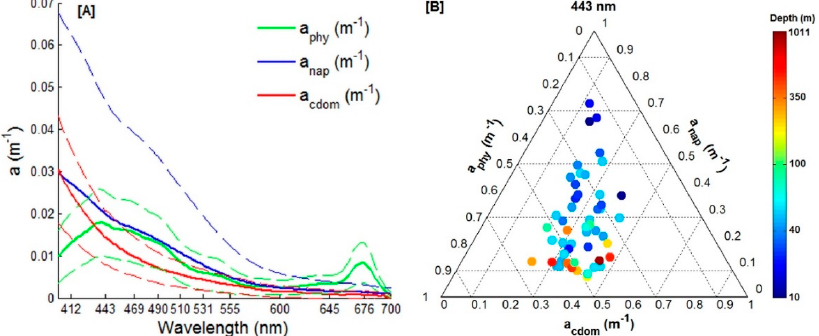
Figure 6. Mean (solid lines) and standard deviation (dashed lines) of phytoplankton absorption ( a phy ), Coloured dissolved organic matter (CDOM) absorption ( a cdom ) and non-algal particles (NAP) absorption ( a nap ) ( A ). Ternary diagram with the proportions of a phy (443), a cdom (443) and a nap (443) for each station (Number of samples = 51) colour coded by the bottom depth (m) ( B ).